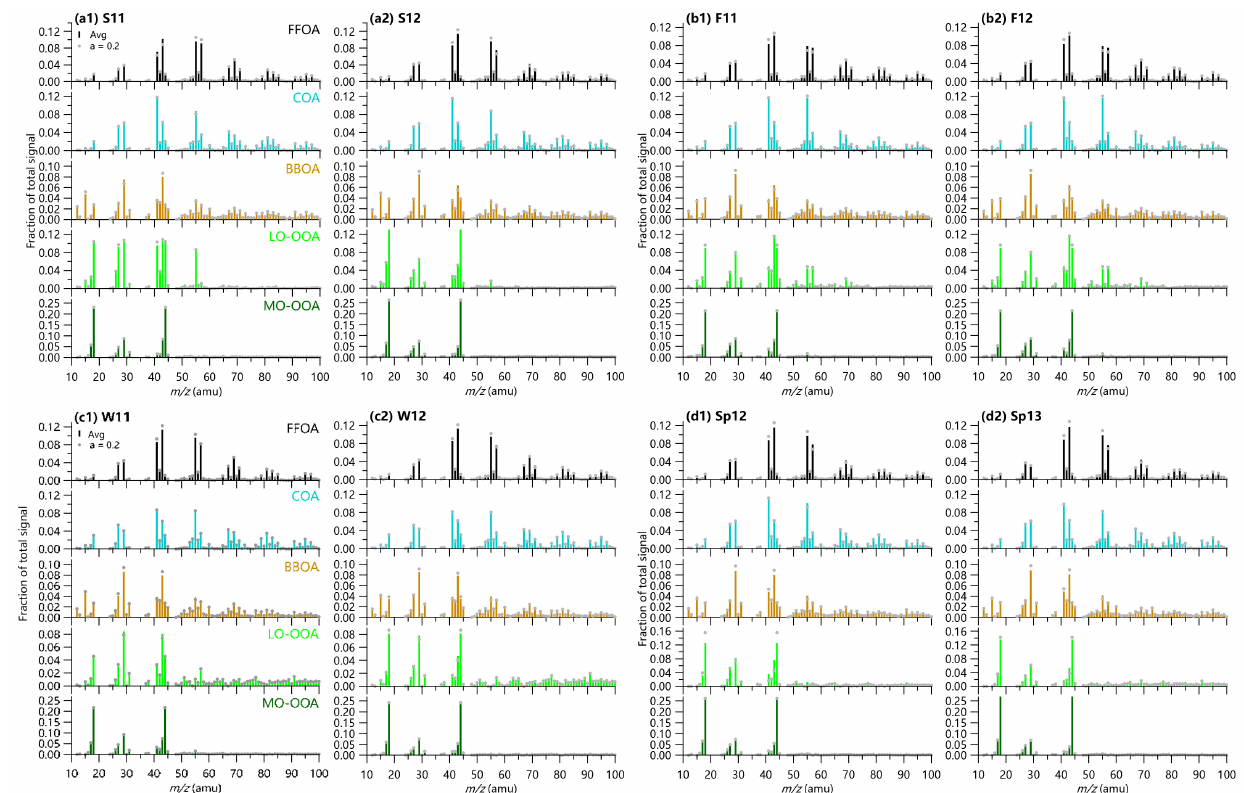
Figure 1. Mass spectral profiles of five OA factors from ME2-ACSM analysis in (a1) S11, summer 2011, (a2) S12, summer 2012; (b1) F11, fall 2011; (b2) F12, fall 2012; (c1) W11, winter 2011; (c2) W12, winter 2012; (d1) Sp12, spring 2012; and (d2) Sp13, spring